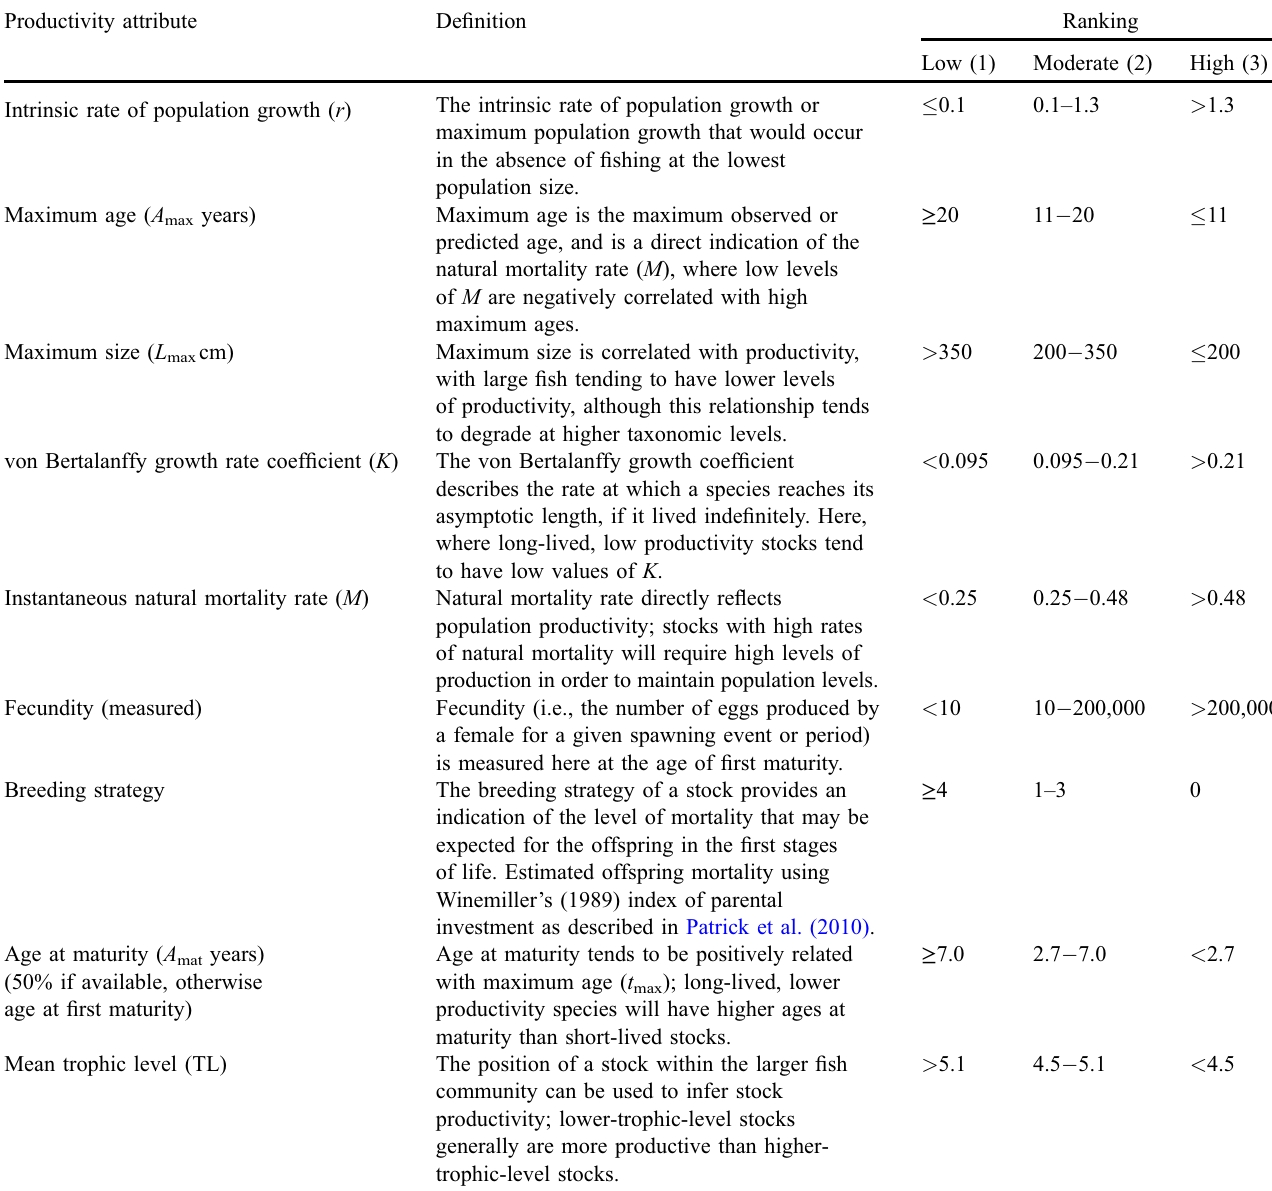
Table 1. Productivity attributes and scoring thresholds used in the example PSA of the eastern Paci fi c Ocean purse-seine fi shery (Duffy et al., 2019). Attribute de fi nitions taken from Table 1 in Patrick et al. (2010) and re fi ned when